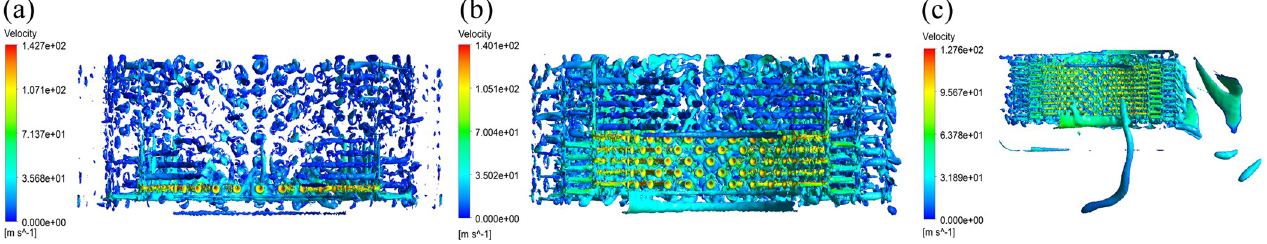
Fig 7. Velocity distributions of the vortex core at different openings. (a) 10% opening. (b) 50% opening. (c) 100% opening.